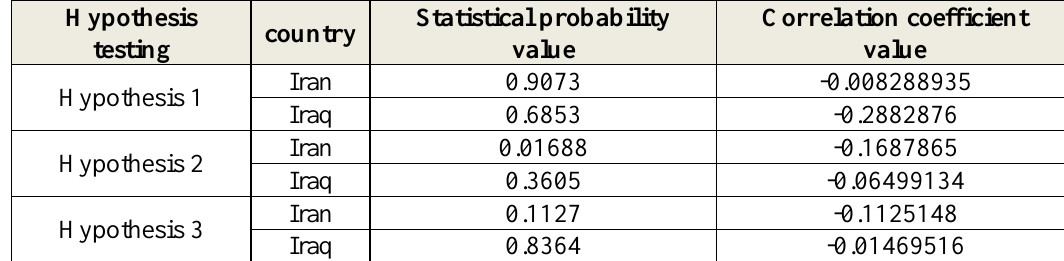
Table 12. Analyzing Spearman’s correlation